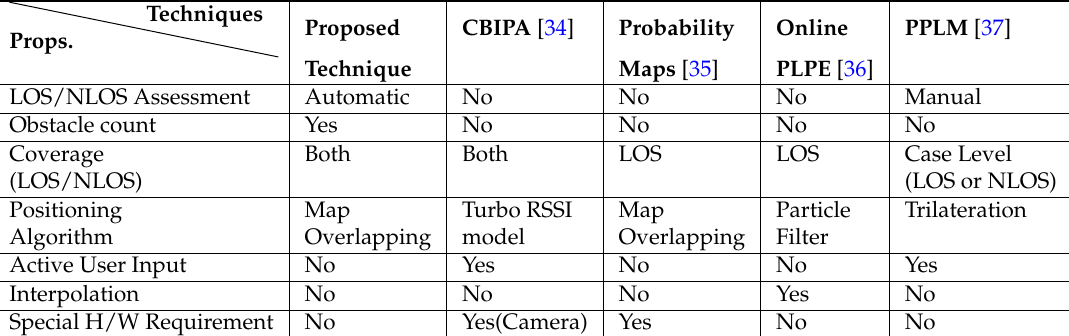
Table 1. Comparison with related techniques.